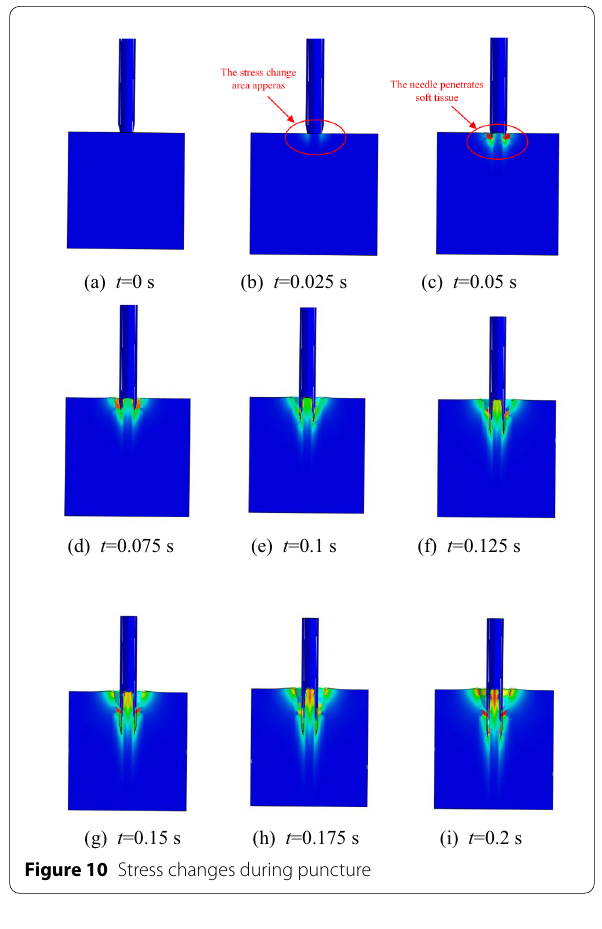
Figure 10 Stress changes during puncture